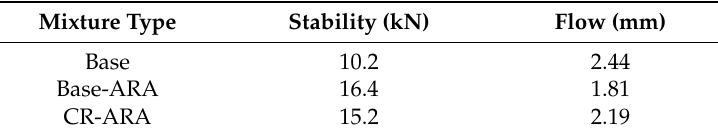
Figure 1. Gradation curves of aggregates used compared with standard requirements. Table 5. Results of Marshall stability test for selected mix.